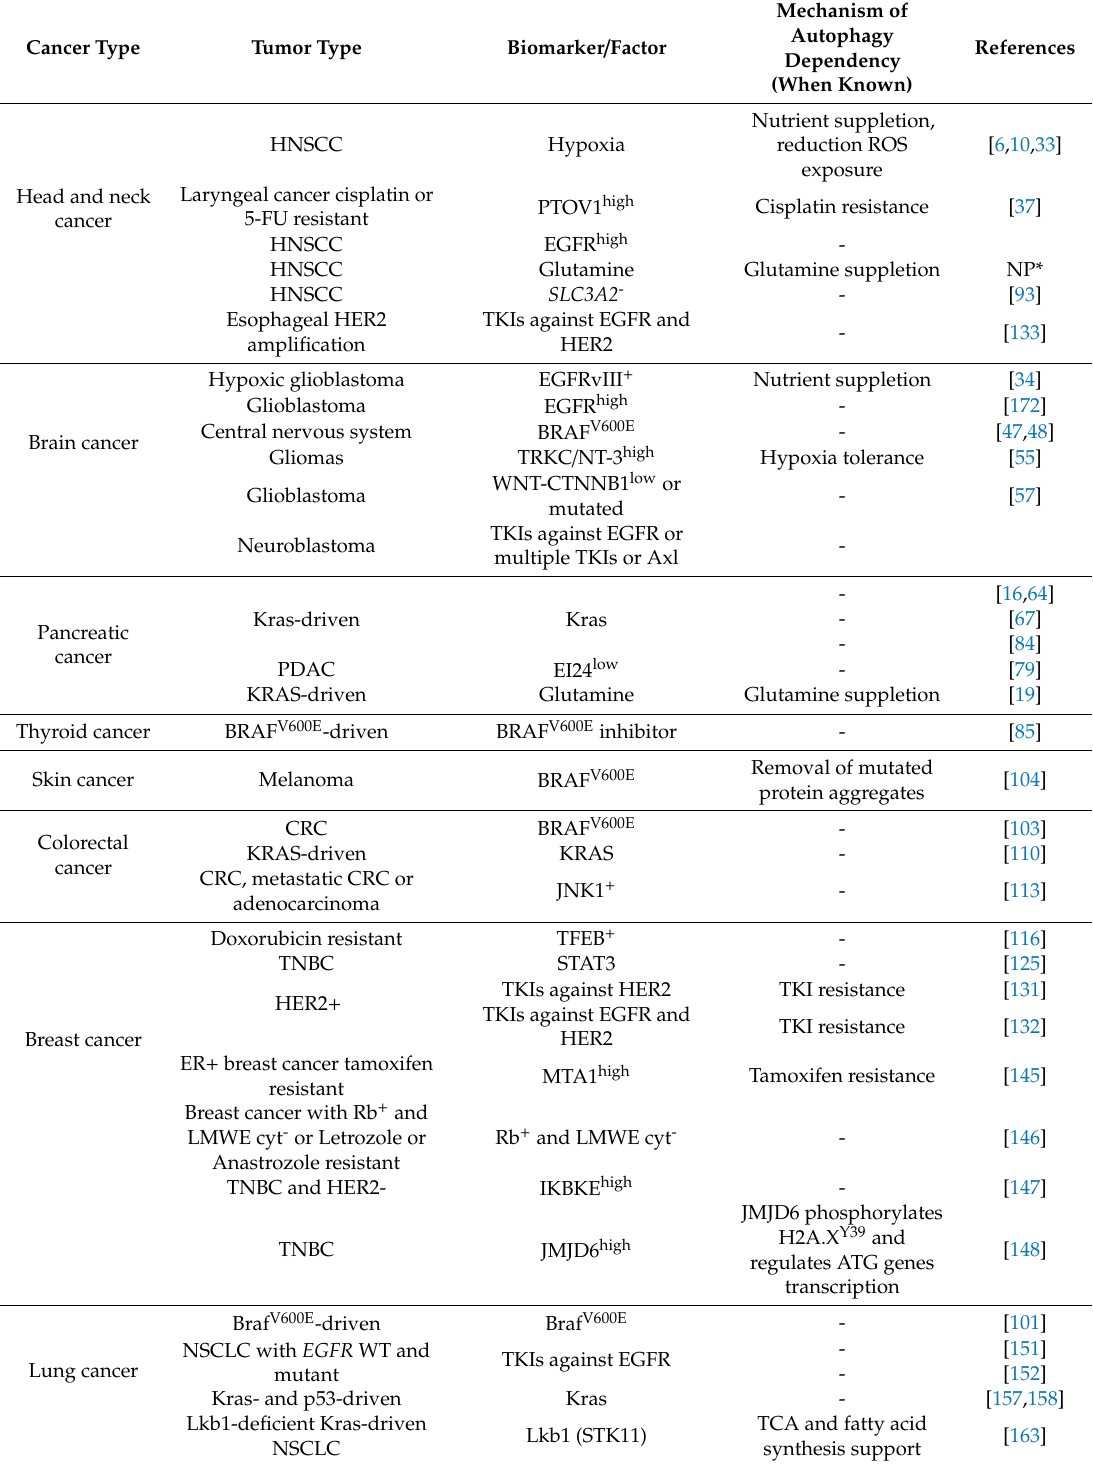
TableA1. Tumor(sub)typesandbiomarkersassociatedwithautophagy-dependenceandtheirimproved combination